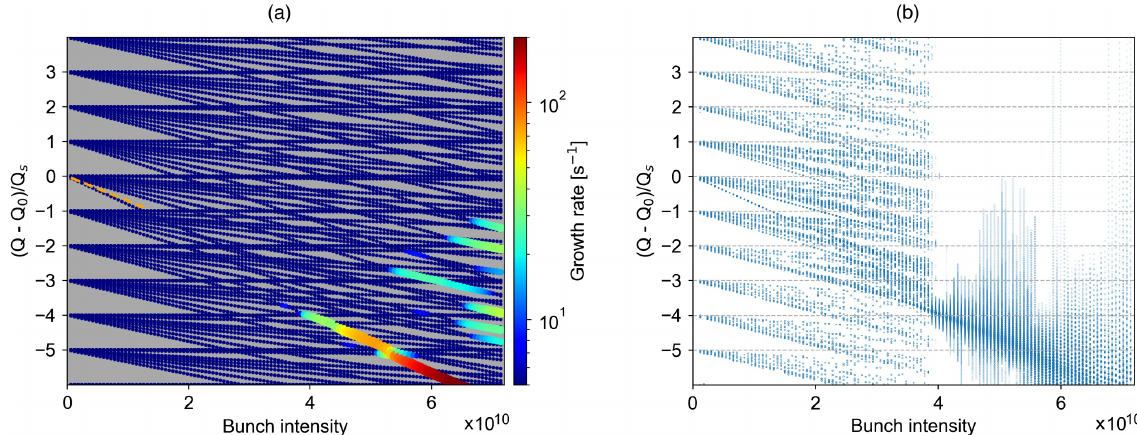
FIG. 14. Same as in Fig. 13 for the case W quad ð z Þ ¼ − W dip ð z Þ . (a) Eigenvalues from linearized Vlasov equation (b) P y HEADTAIL simulations.